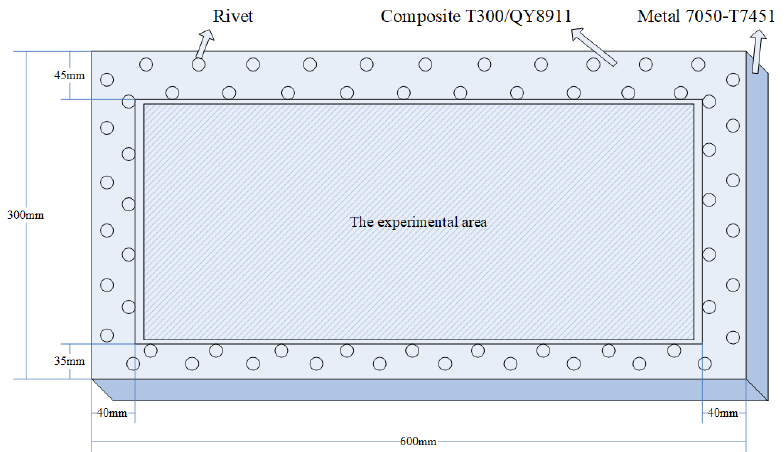
Figure 1. The composite laminate on the surface of the wing tank specimen and the impact experi- mental area.